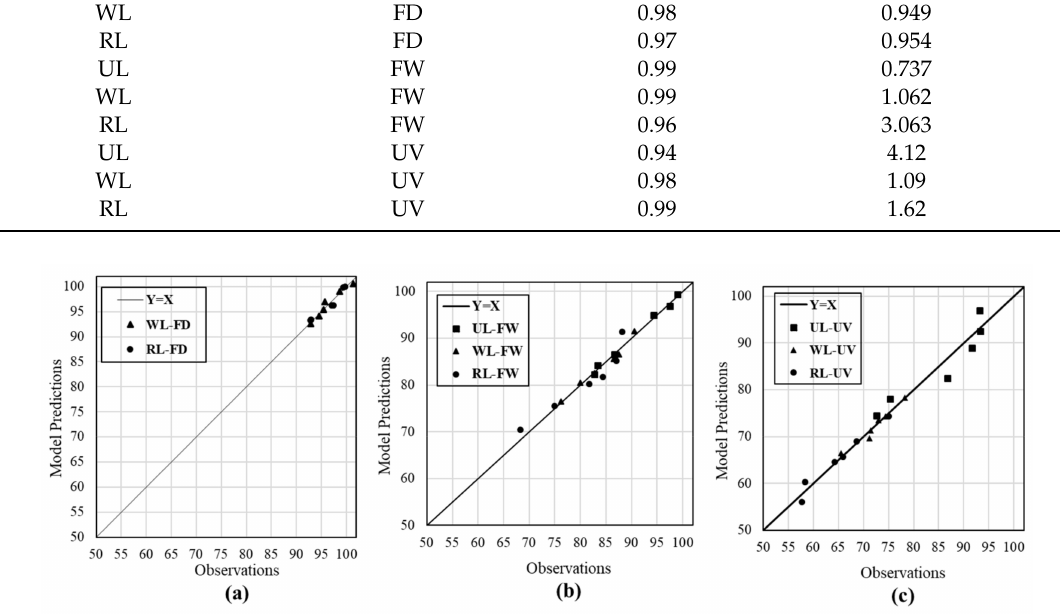
Figure 16. Comparison between the test results and model predictions: ( a ) FD, ( b ) FW, and ( c )